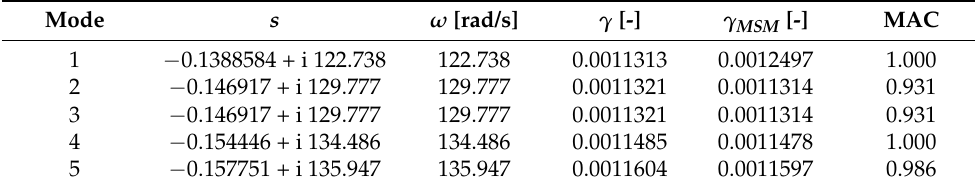
Table 3. Dome 2—NEP eigenvalues, natural frequency, non-dimensional damping ratio and MAC.